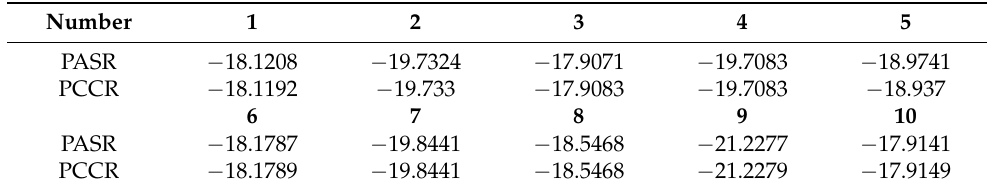
Table 5. OFDM-NLFM waveform set design results when the segmentation parameters set